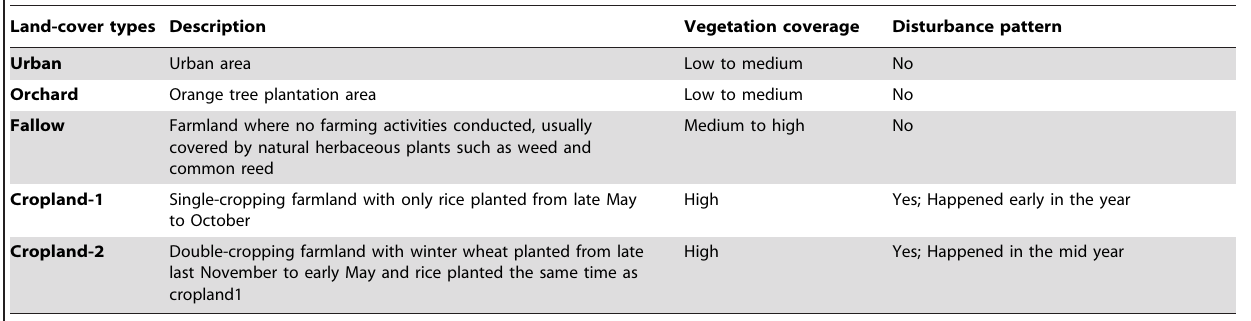
Table 2. Descriptions of different land-cover types in study area.